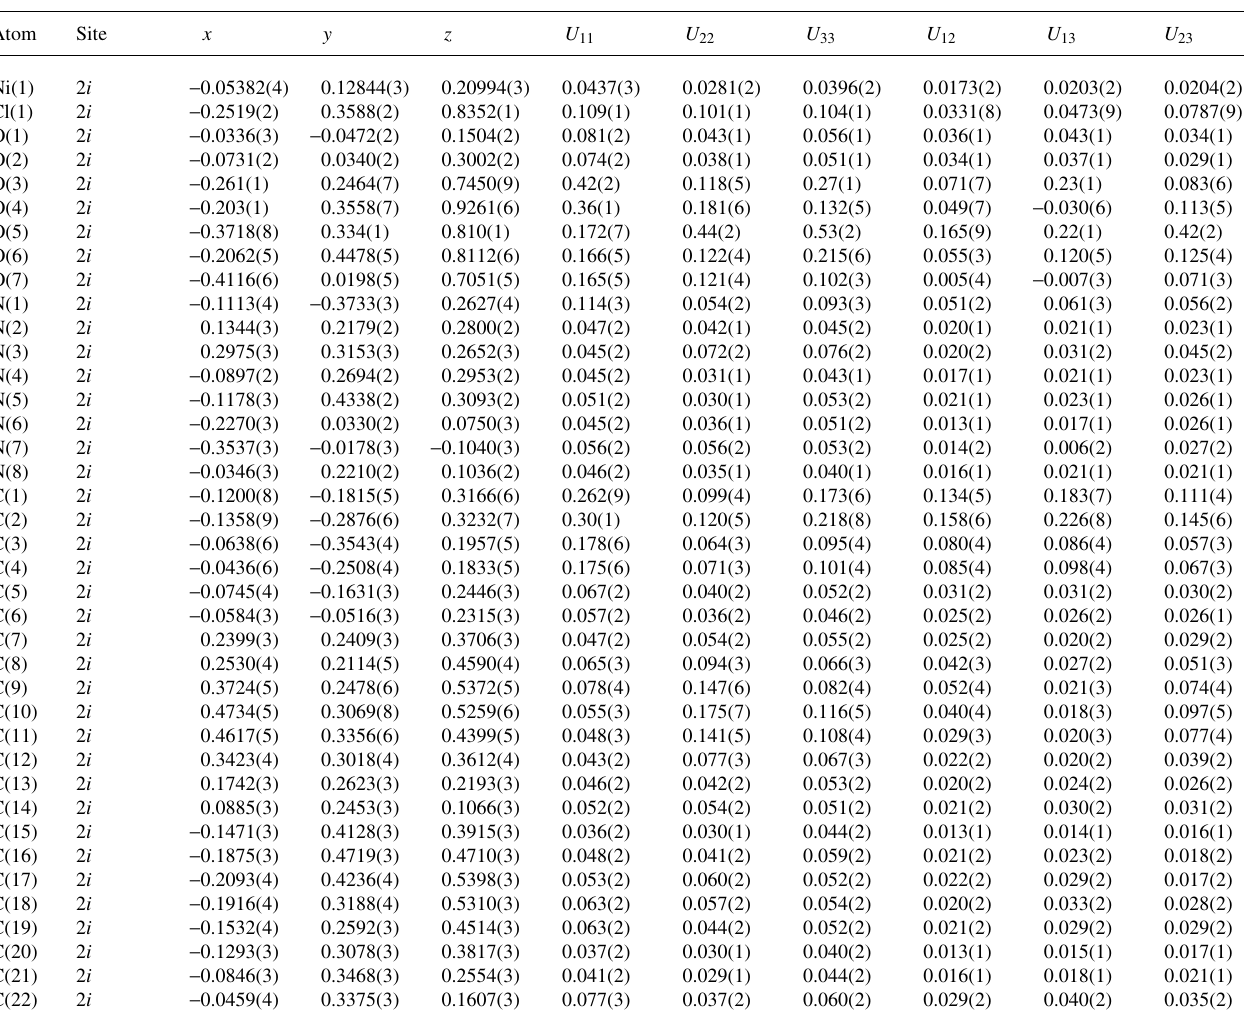
Table 3. Atomic coordinates and displacement parameters (in Å 2 ) .